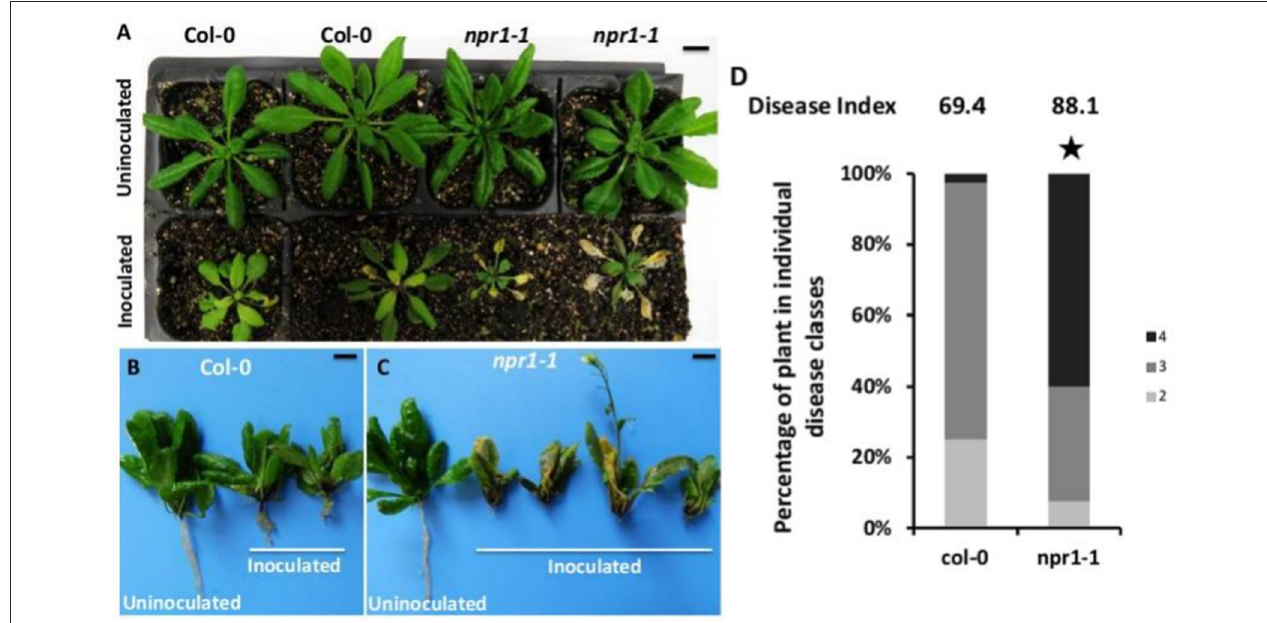
FIGURE 8 | Gall phenotype and phytopathological analysis of the wild type compared with npr1-1 mutant plants at 21 days post inoculation with P. brassicae . (A) Mature shoot phenotypes of wild-type and mutant plants. The top of the picture shows uninoculated plants, and the bottom of the picture shows plants inoculated with P. brassicae. The left two panels show Arabidopsis Col-0 plants, while the right two panels show npr1-1 mutant plants. (B) Gall phenotype of Arabidopsis Col-0. (C) Gall phenotype of npr1-1 mutants. (D) Phytopathological analysis of wild type and mutant plants. The percentages of plants in the individual disease classes are shown. For each treatment, 40 Arabidopsis plants were analyzed. The qualitative disease assessment data were initially analyzed using spss and subsequently further analyzed after comparing the mean rank differences. The asterisk indicates a significant difference at P < 0.01. The disease index for each sample is shown as a number above the respective